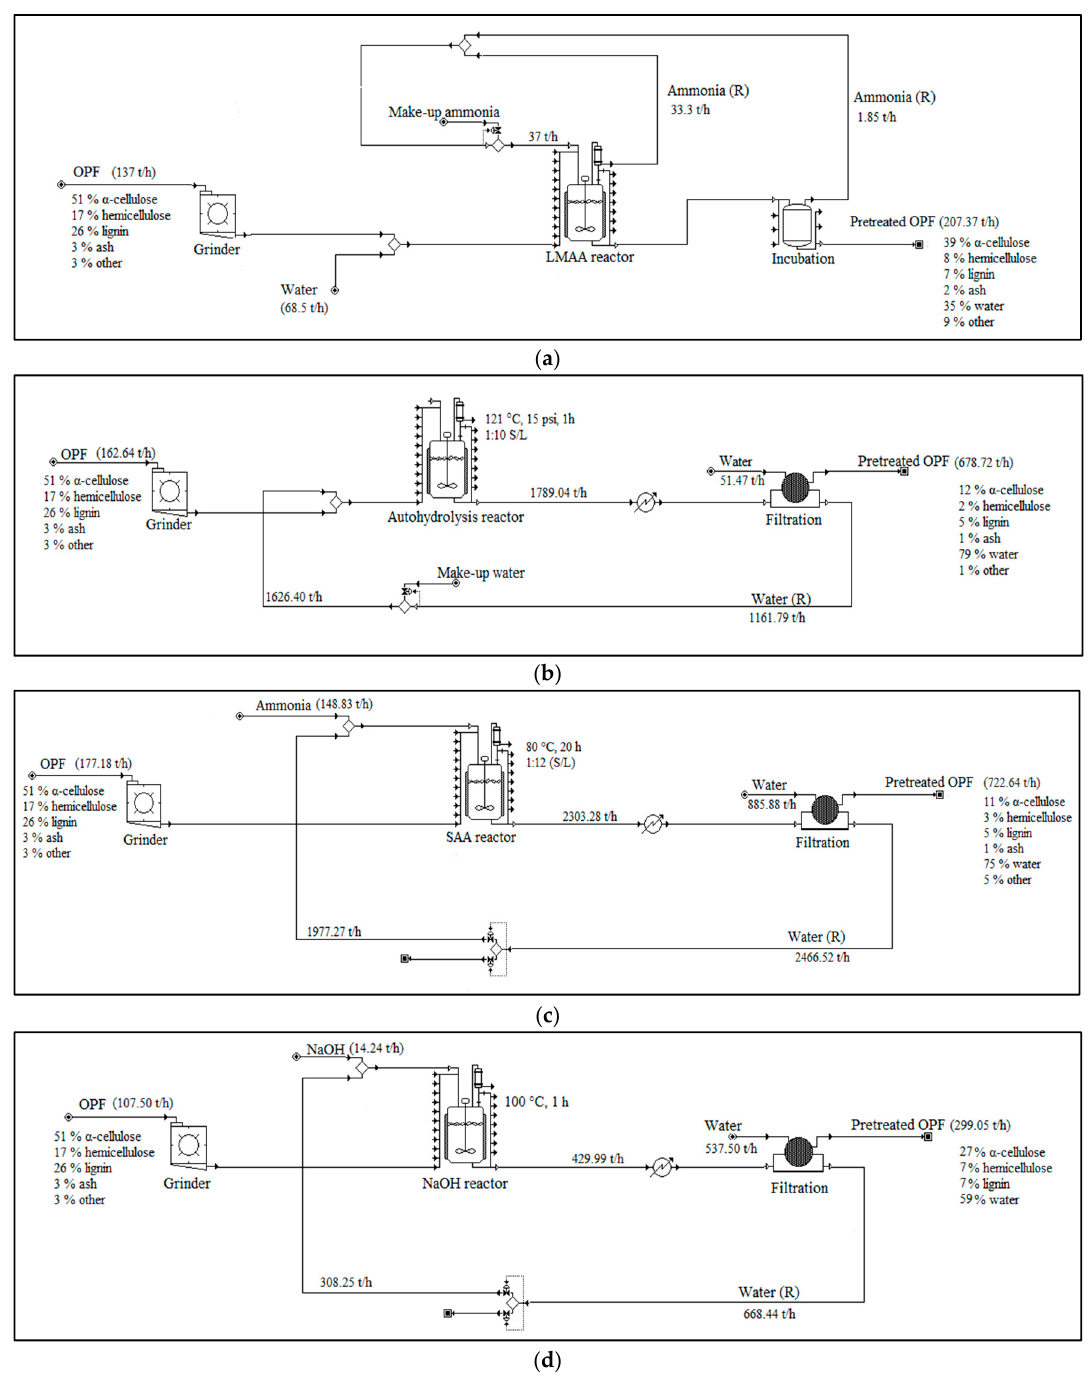
Figure 4. Pretreatment set-ups used in the simulation models. Note that this figure only includes major unit operations. More detailed plant set-ups were actually used in the simulations. ( a ) LMAA pretreatment; ( b ) autohydrolysis pretreatment; ( c ) SAA pretreatment; ( d ) NaOH pretreatment; (R) = recycle.